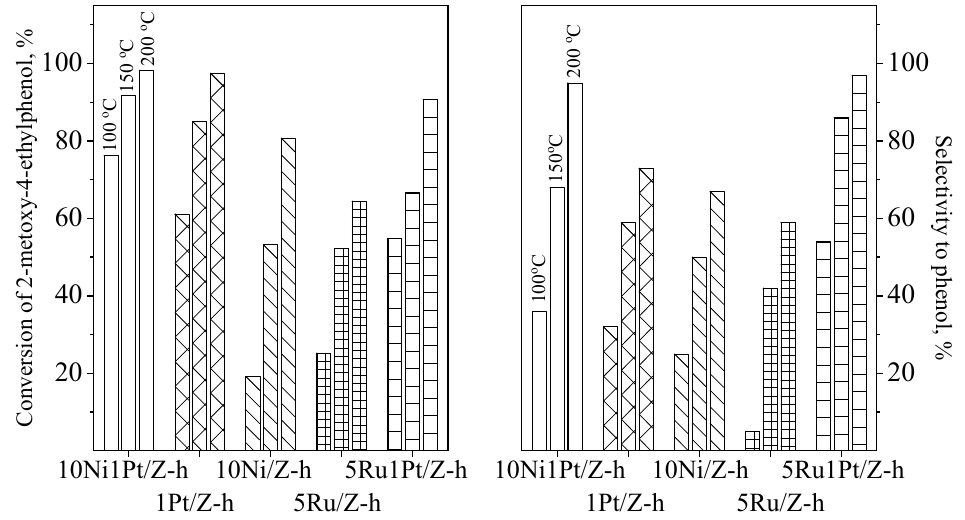
Figure 10. The catalytic activity ( left ) and selectivity to phenol( right ) of the Ni-, Ru-, and Pt-modified hierarchical ZSM-5 zeolites in hydrodemethoxylation of 2-methoxy-4-propylphenol.